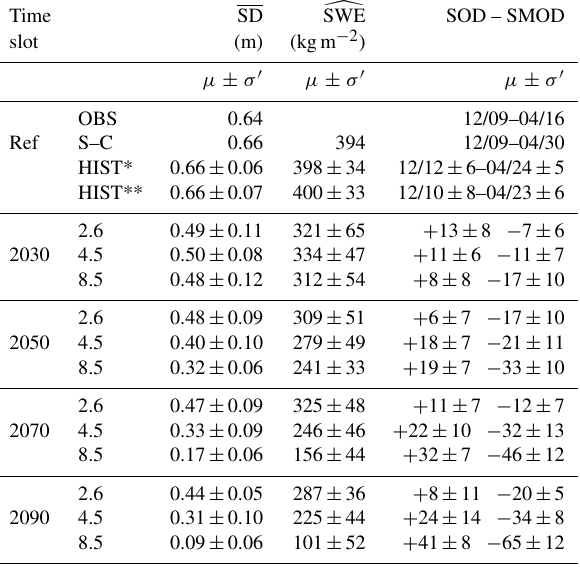
Table 4. Reference values of T , P and R for the period 1986–2005 (Ref) from observations (OBS, only µ ), SAFRAN (SAF, only µ ) and the historical scenario (HIST, * 13 GCM–RCM pairs, ** 4 GCM–RCM pairs corresponding to the ones in RCP2.6). Change ( µ ± σ (cid:48) ) in those indicators ( (cid:49)T , ρP and (cid:49)R ) for the same time slots and RCPs as in previous tables, compared to the reference pe- riod 1986–2005 in HIST*. Time slot